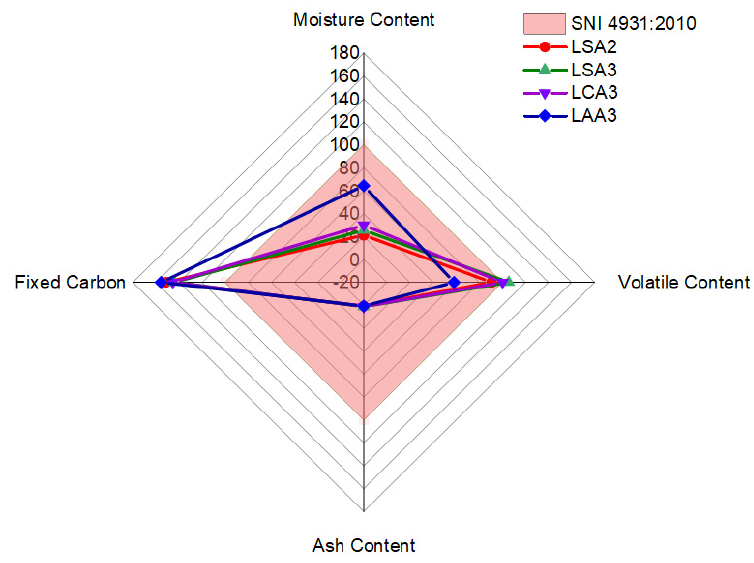
Figure 7. Summary of proximate analysis result.